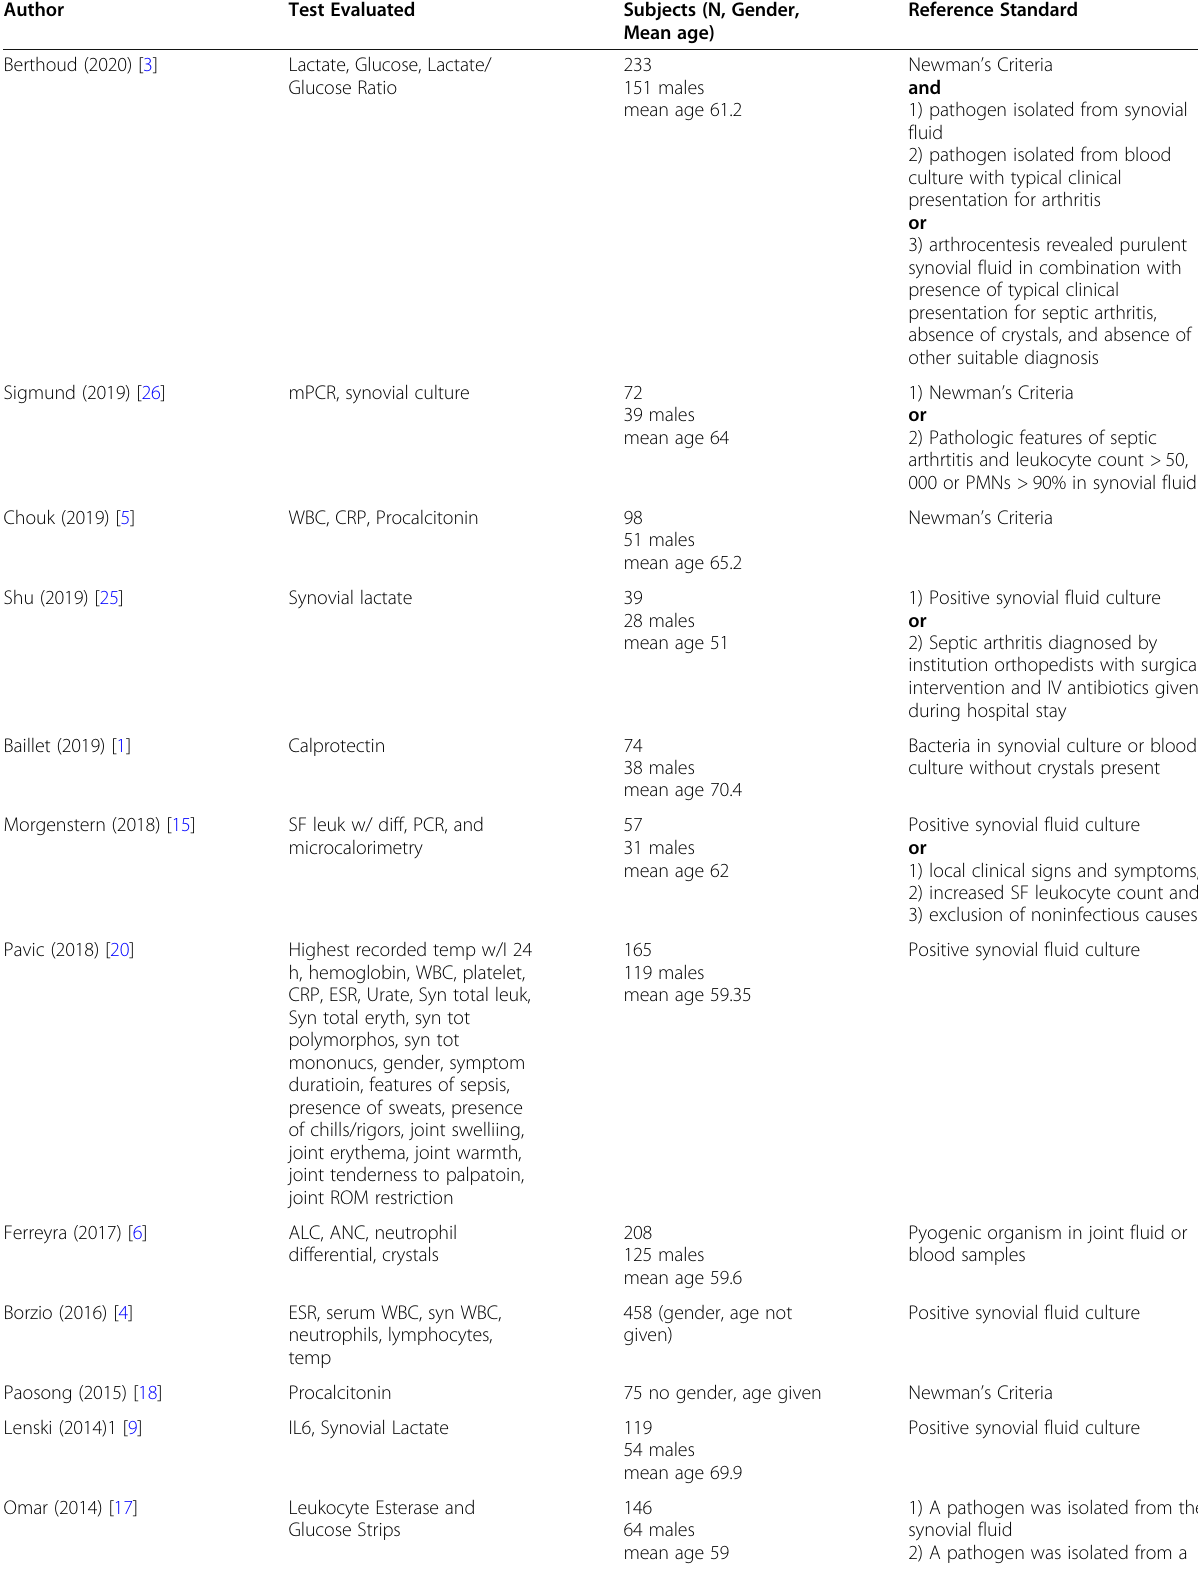
Table 1 Characteristics of Included